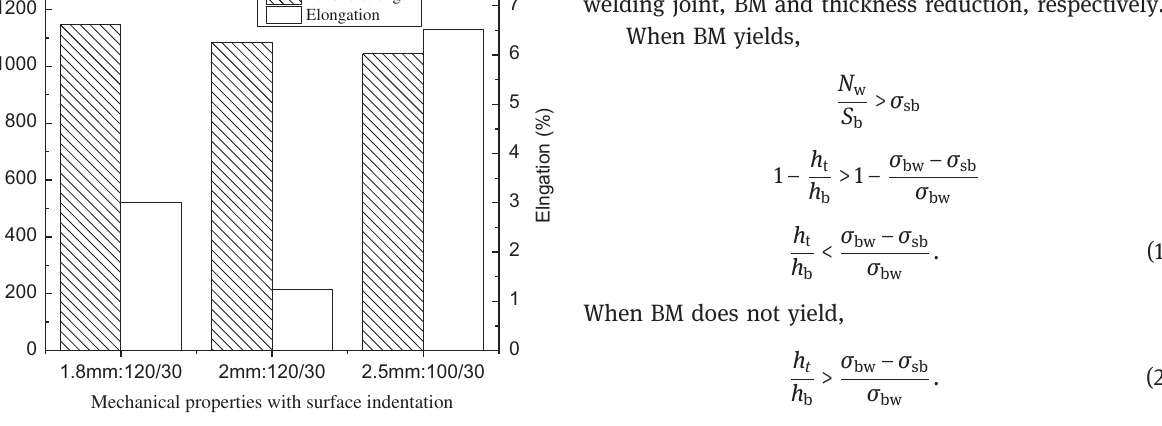
Figure 5: Tensile properties of different thick joints with surface indentation.